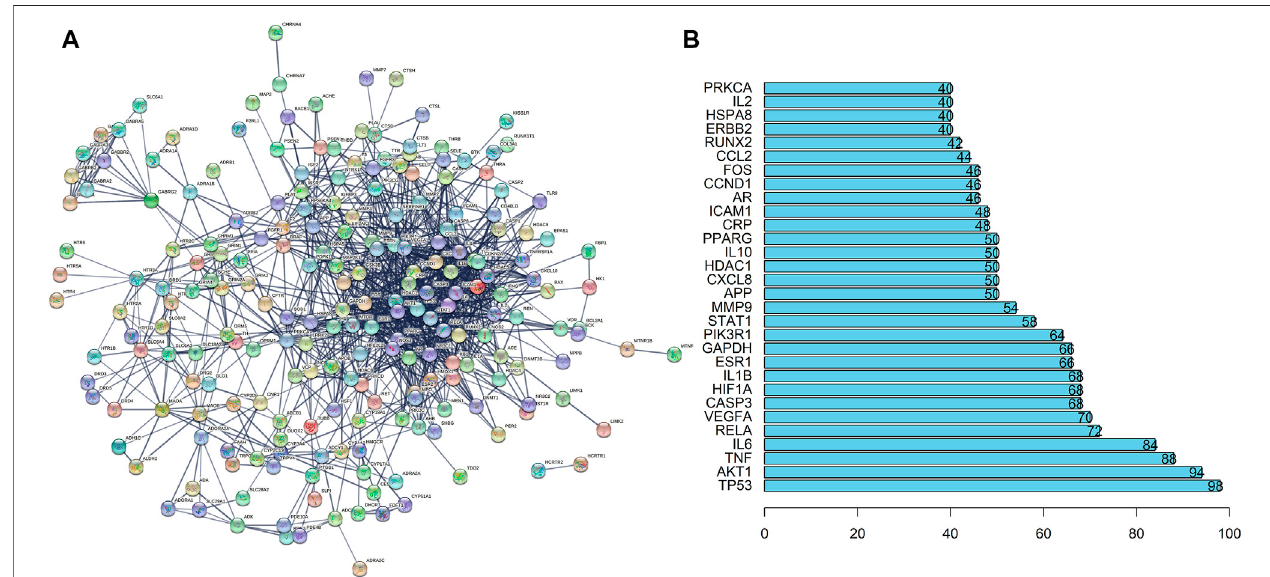
FIGURE3| PPINetworkAnalysisofintersectiontargets. (A) PPInetworkofpotentialsleepdisordertargetsactedbymajoractivecomponentsofSMC.Therewere 242 nodes and 1062 edges in the PPI network. (B) The top 30 genes in the PPI network.